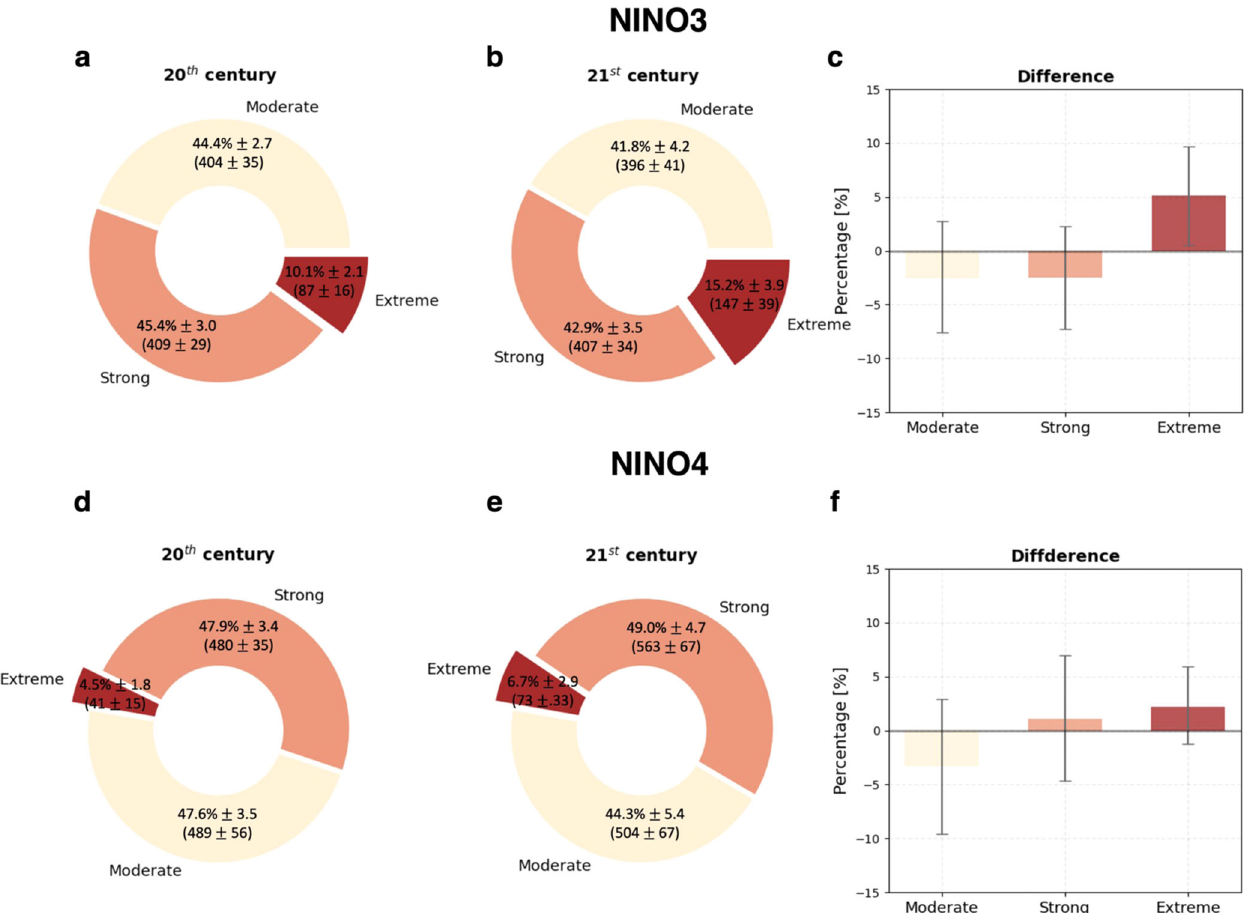
Fig. 3 Changes in extreme El Niño event occurrences in a warming climate. Ratios of moderate, strong, and extreme El Niño events in 30 CMIP6 models based on Niño3 SSTA ( a – c ) and Niño4 SSTA ( d – f ). a , d are for the 20th century, b , e 21st century, and c , f their difference, respectively. Each Niño index is normalized by STD of each model in the 20th century. De fi nitions of moderate, strong, and extreme El Niño events are based on [0.5 – 1STD], [1 – 2STD], and [>2STD], respectively. The value in parentheses is the number of events. The error bars indicate the 95% con fi dence level using the bootstrap method